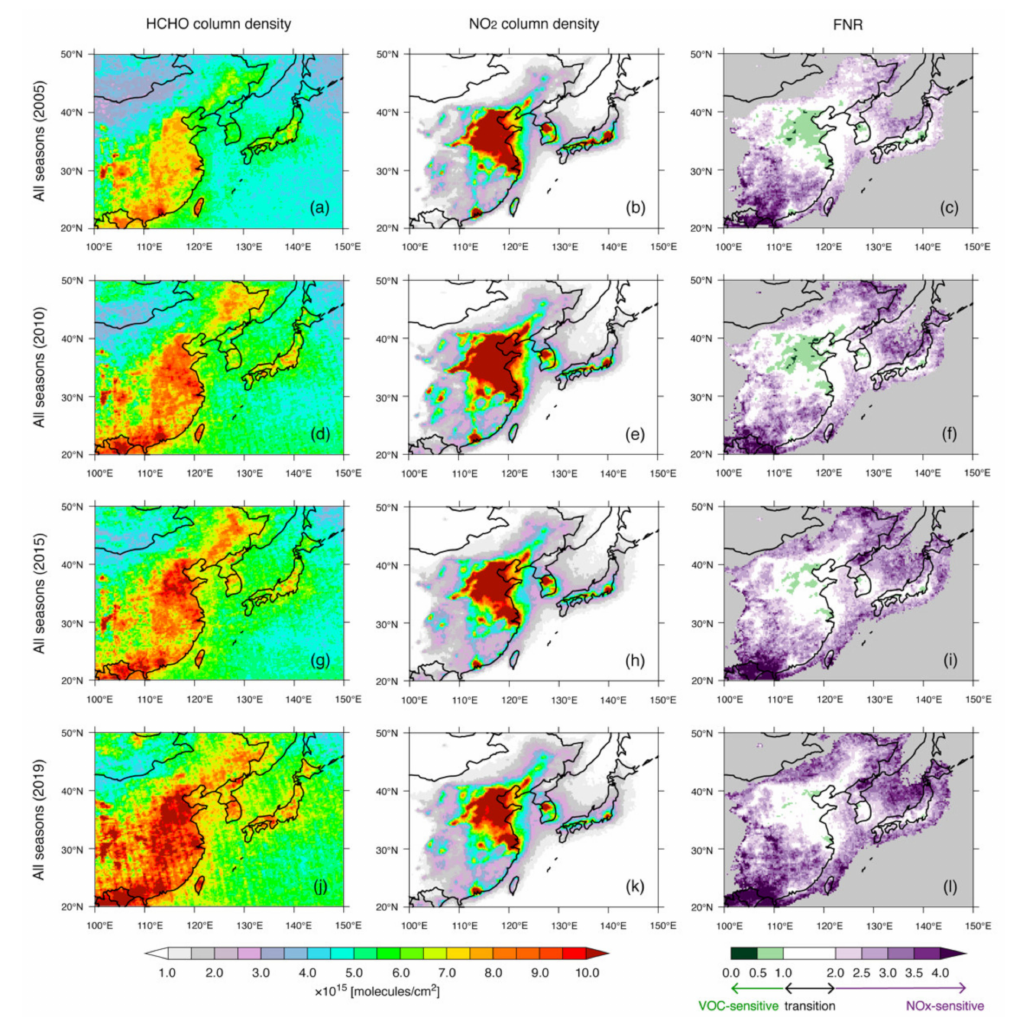
Figure 2. Spatial distribution of ( a , d , g , j ) HCHO column density, ( b , e , h , k ) NO 2 column density, and ( c , f , i , l ) FNR over East Asia averaged over all seasons for the year ( a – c ) 2005, ( d – f ) 2010, ( g – i ) 2015, and ( j – l ) 2019. FNR is analyzed at grid points where NO 2 column density is greater than 1.0 × 10 15 molecules cm − 2 (white in ( b , e , h , k